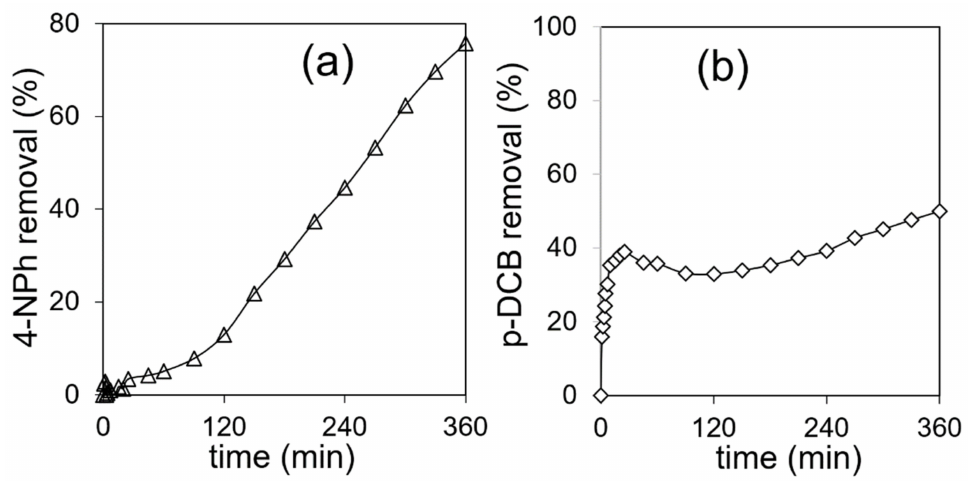
Figure 8. Pollutant % removal of: ( a ) 4-NPh; and ( b ) p-DCB from an aqueous solution containing both pollutants on Ag_MgGaAl.